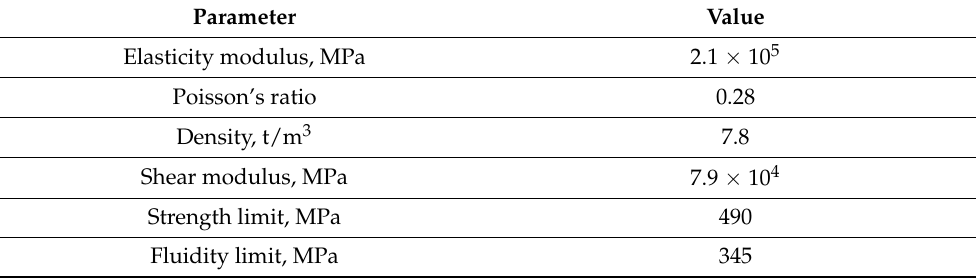
Table 1. Basic technical characteristics of Steel 09C2Cu.